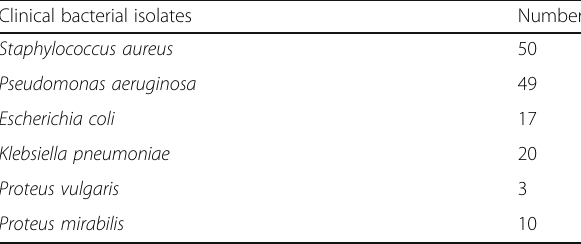
Table 1 Clinical bacterial isolates Clinical bacterial